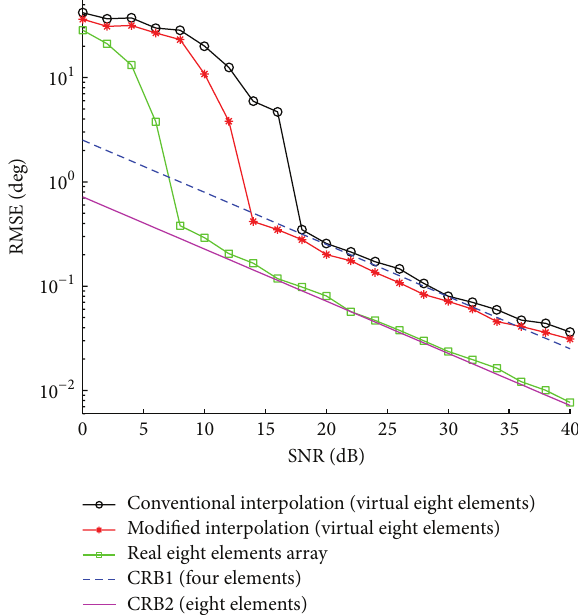
Figure 6: RMSE versus SNR for MUSIC-based